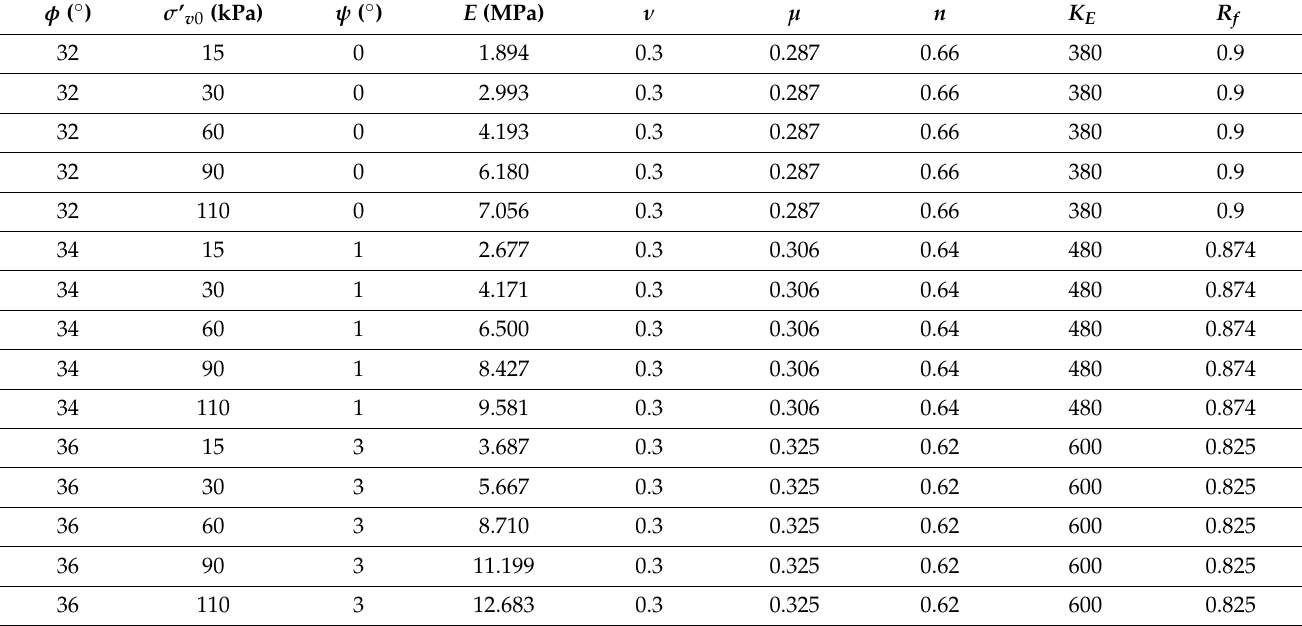
Table 2. Parameters used in the finite element analysis.